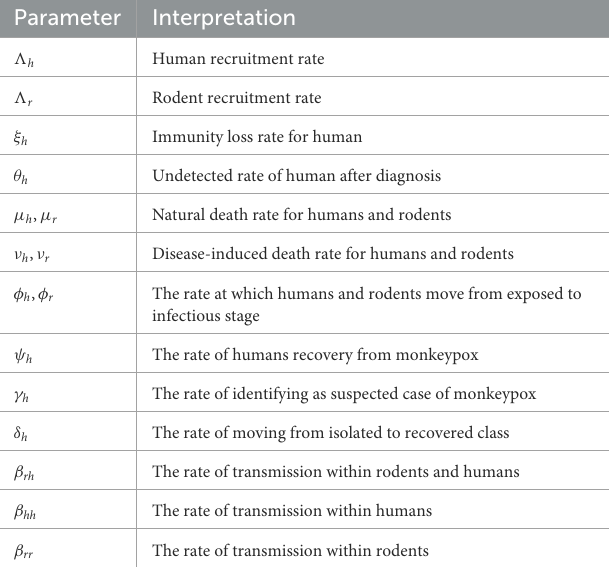
TABLE 1 Interpretation of parameters in the